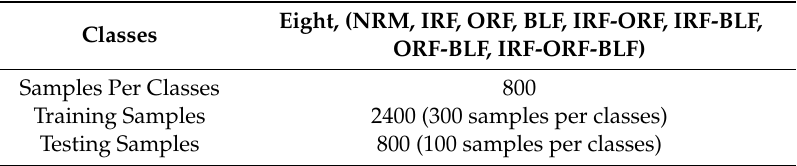
Table 4. Window Characterization for Training and Testing: SHSE Lab Dataset.